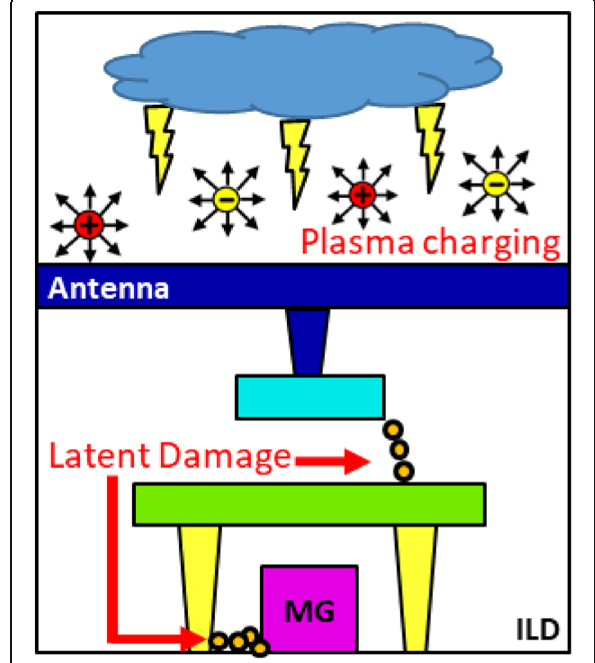
Fig. 1 Plasma-induced damages in inter-metal dielectric layers between tightly packed interconnect patterns can link to latent degradation on its isolation integrity